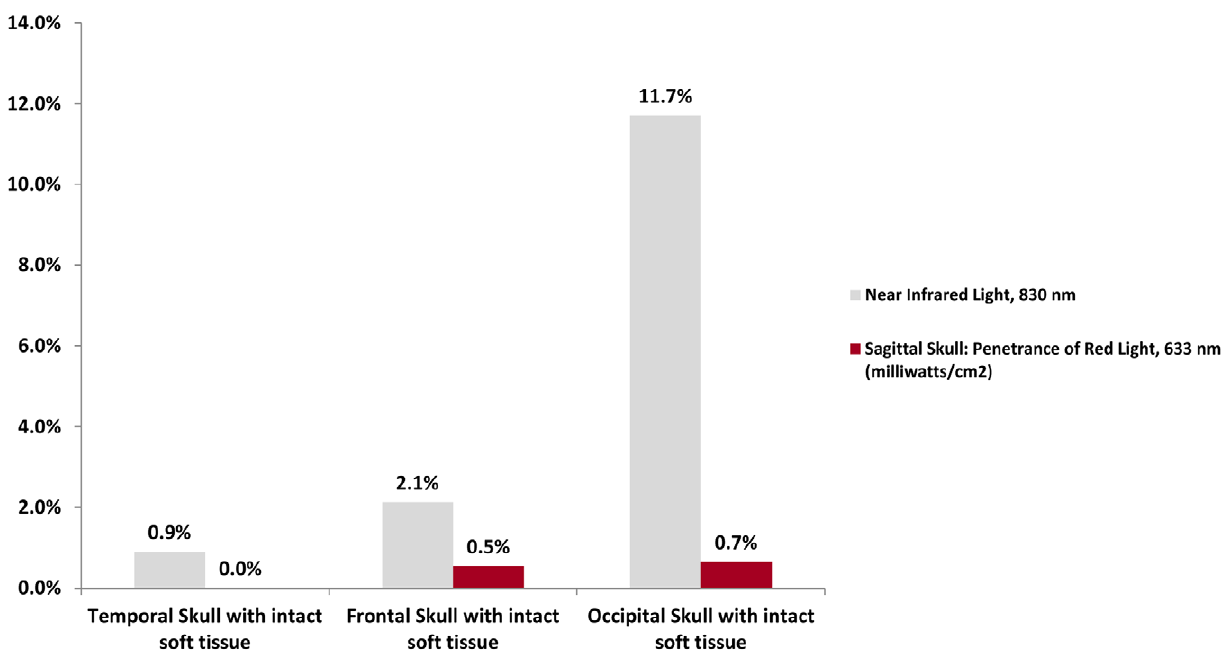
Figure 3. Percent Penetrance of Light through Sagittal Sections of Cadaver Skull with Intact Soft Tissue. Near infrared light measurably penetrates cadaver skull with intact soft tissue, as compared to red light.